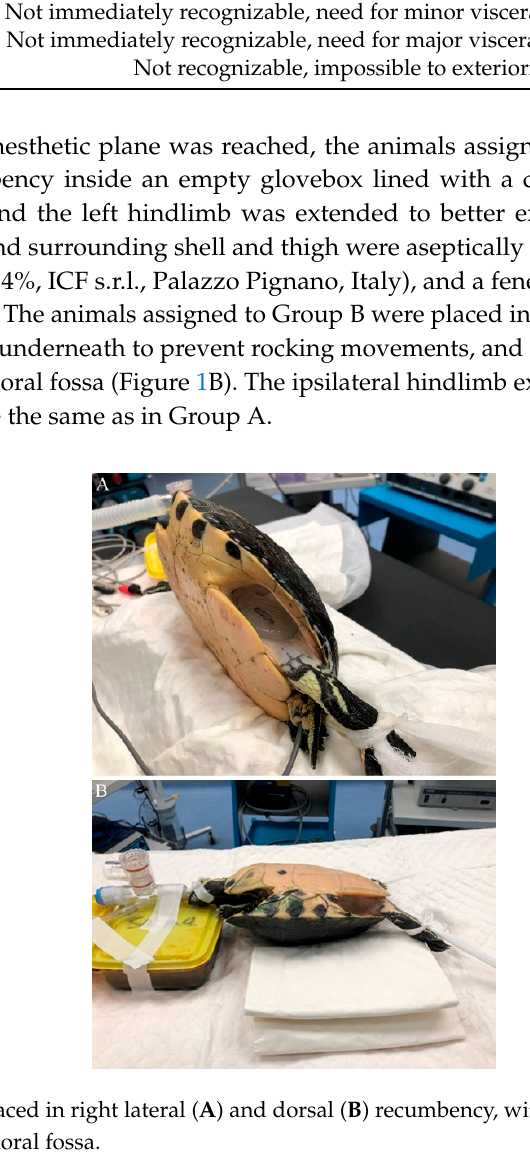
Table 2. Scoring system for ease of identification of the ovary opposite to the surgical incision, modified from Divers et al., 2010.